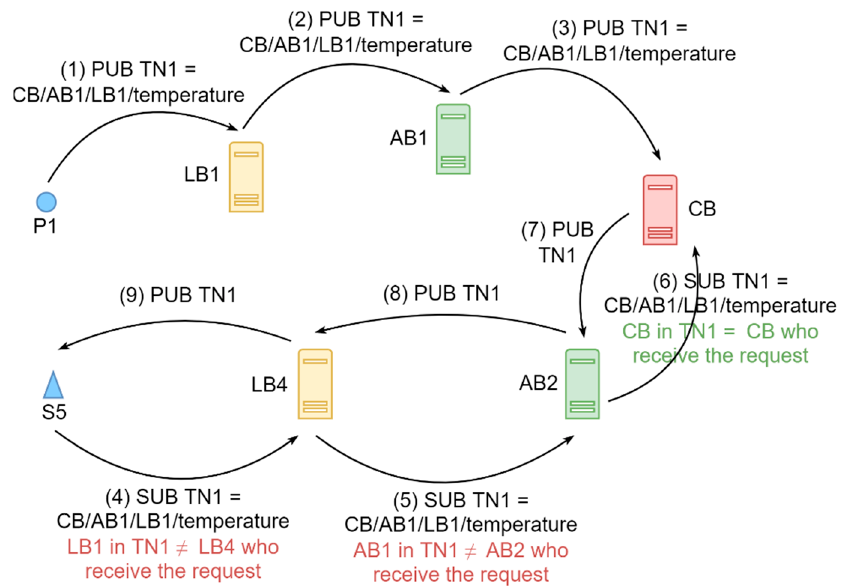
Figure 5. Third communication scenario.